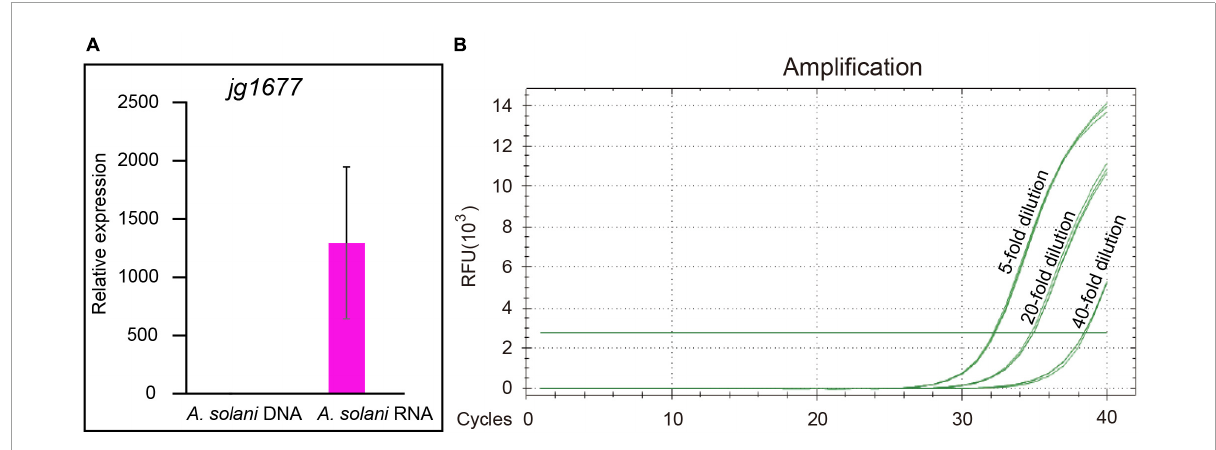
FIGURE3 Comparison of the sensitivity of RNA-based and DNA-based detection methods. (A) qPCR using DNA and RNA to detect A. solani jg1677 expression levels. Data are shown as means ± SD. Error bars represent SD. (B) Standard curves for qPCR detection of A. solani using single spore cDNA samples diluted fivefold, 20-fold, and